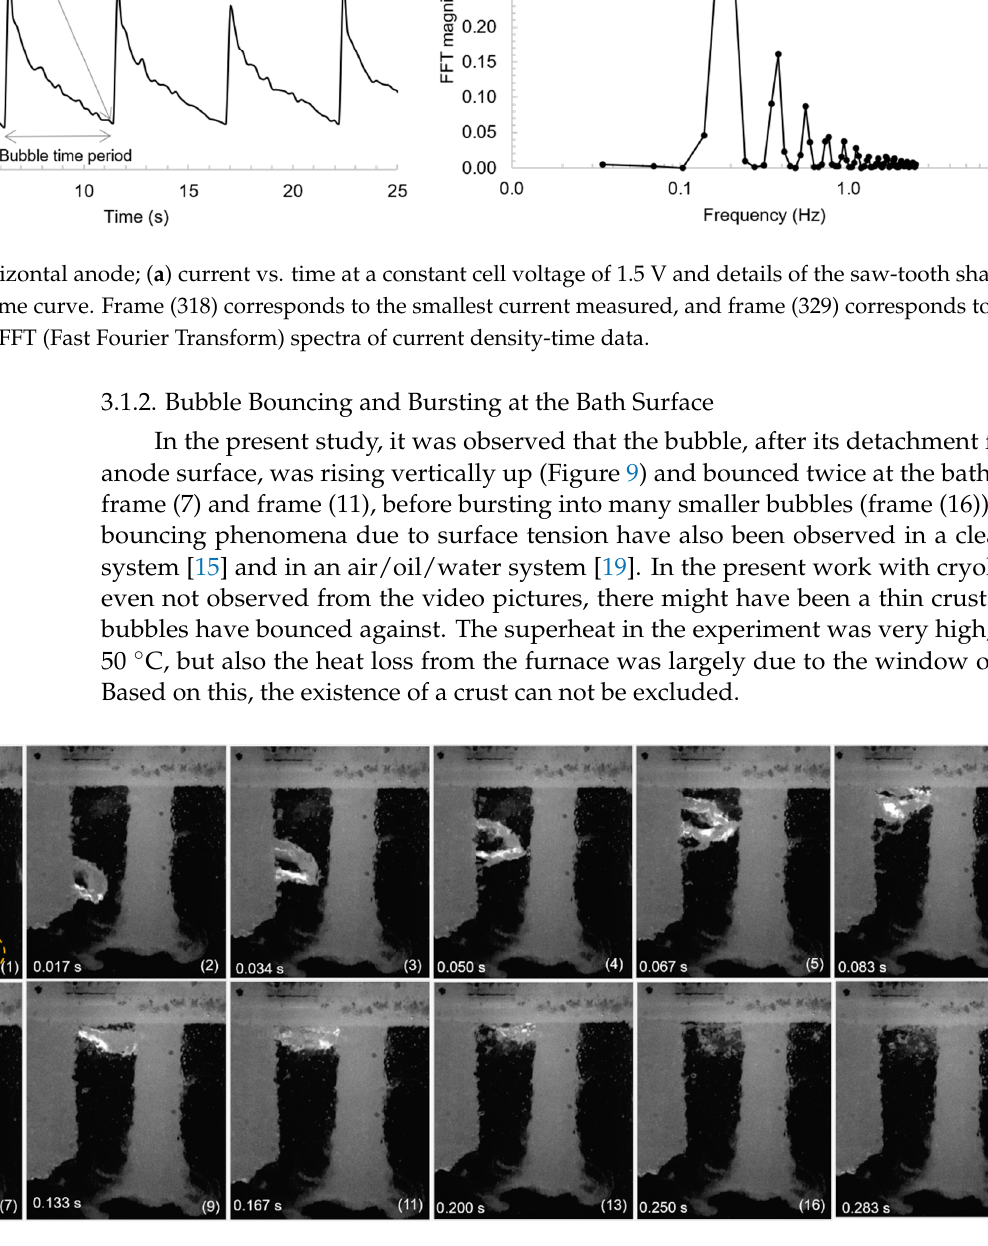
Figure 8. The horizontal anode; ( a ) current vs. time at a constant cell voltage of 1.5 V and details of the saw-tooth shaped current density-time curve. Frame (318) corresponds to the smallest current measured, and frame (329) corresponds to the current peak. ( b ) FFT (Fast Fourier Transform) spectra of current density-time data.